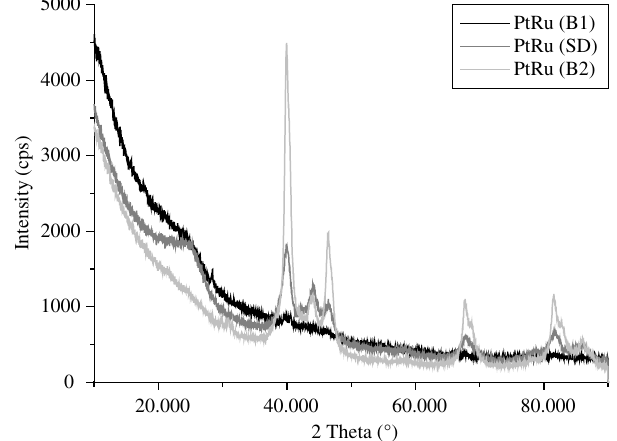
Figure 2. Diffractograms of the catalysts PtRu (B1), PtRu (B2) and PtRu (SD).